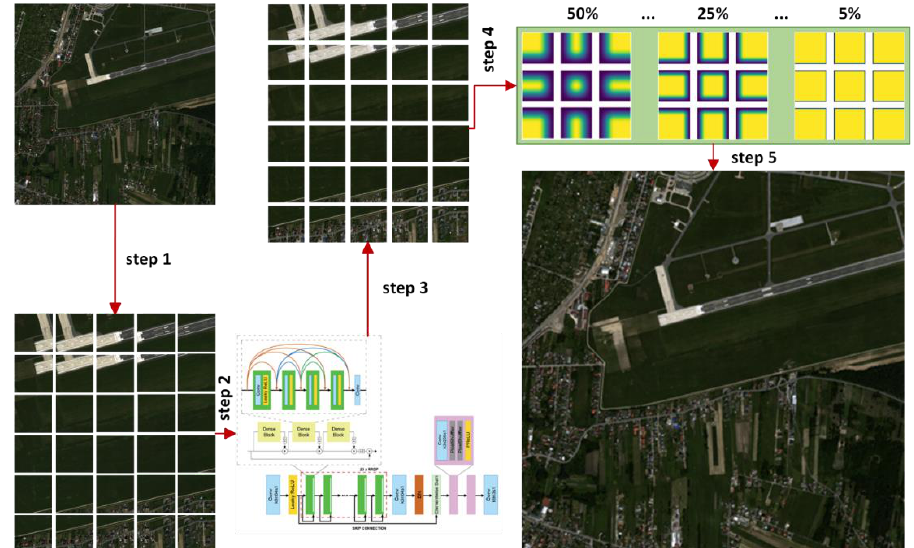
Figure 2. Diagram of the methodology to improve the resolution of whole satellite scenes. Step 1: divided of image, step 2: upload images to the network, step 3: use a method of improving spatial resolution using neural networks, step 4: select a window function to combine images, step 5: combine images.